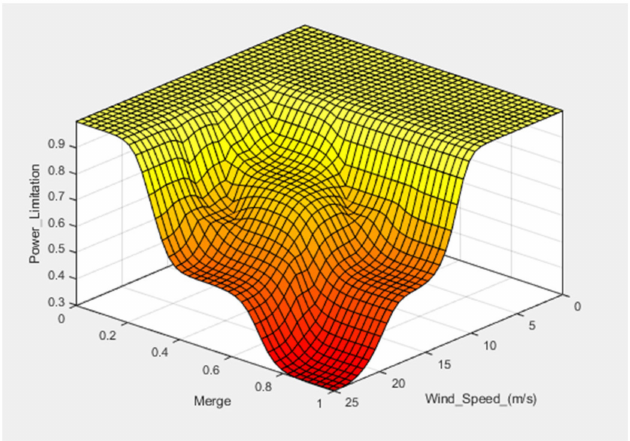
Figure 8. Surface associated with the wind– merge controller.